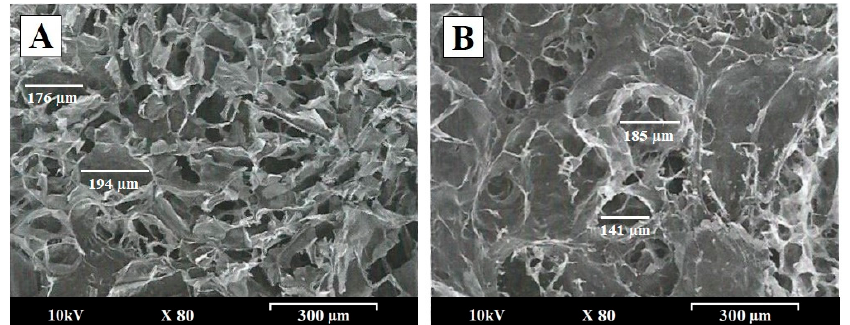
Figure 1. Scanning electron micrographs of CL:(CS:CMC) tablets with different (CS:CMC) propor- tions. PEC tablets of ( A ) CL:(CS:CMC) 80:(18:2) ( w/w ) and ( B ) CL:(CS:CMC) 40:(30:30) ( w/w ), after 1 h at pH 4.2. Original magnification is 80× and the scale bar is equal to 300 μ m. After 1 h in the dissolution medium (acetate buffer, pH 4.2), the PEC tablets